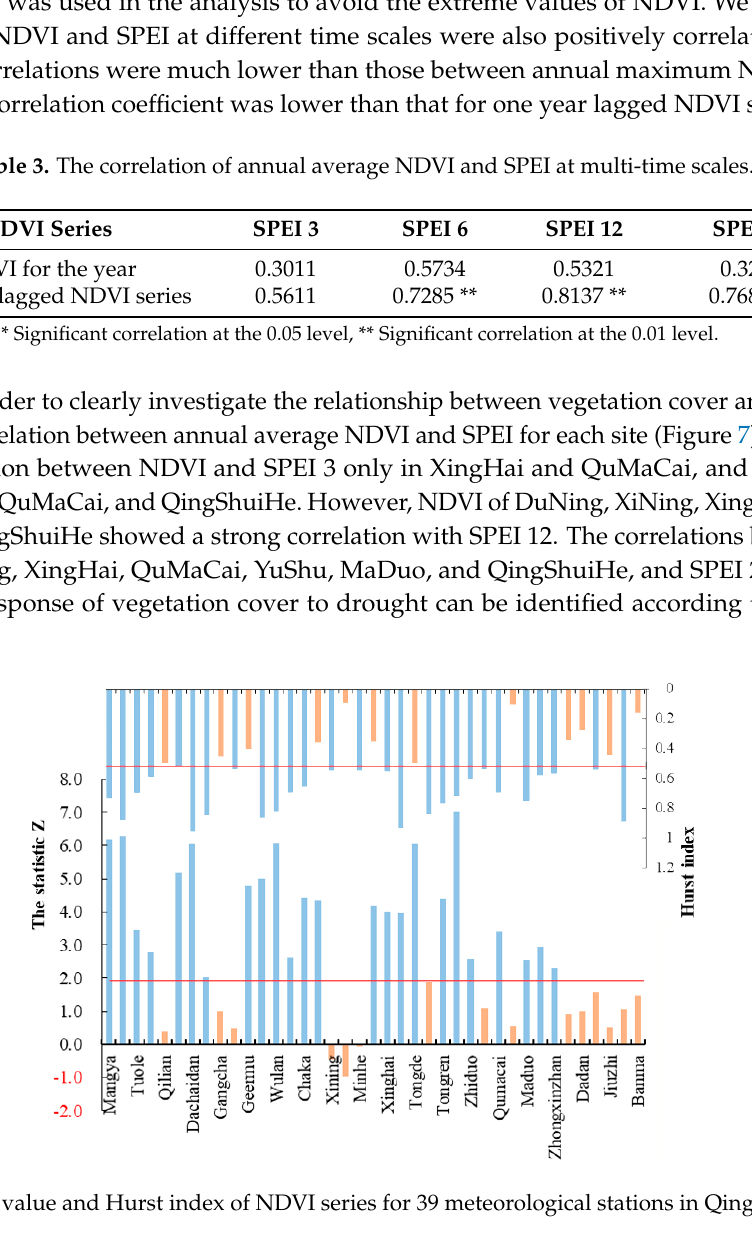
Table 2. The correlation of annual maximum NDVI and SPEI at multi-time scales.